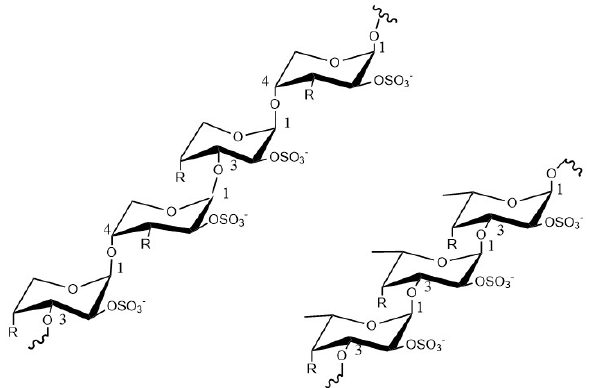
Figure 1. The structure of fucoidan.